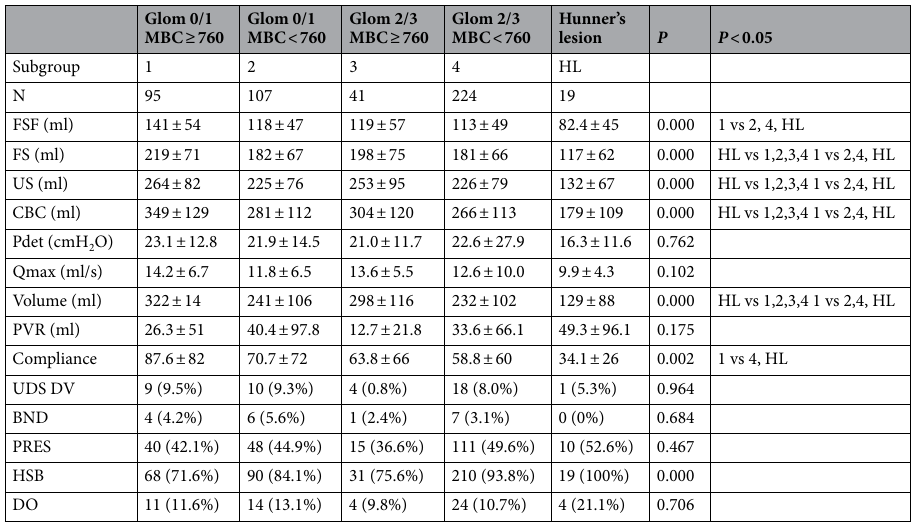
capacity (ml); FSF, first sensation of filling; FS, full sensation; US, urge sensation; CBC, cystometric bladder capacity; Pdet, voiding detrusor pressure; Qmax, maximum flow rate; PVR, post-void residual urine; UDS, urodynamic study; DV, dysfunctional voiding; BND, bladder neck dysfunction; PRES, poor relaxation of external sphincter; HSB, hypersensitive bladder; DO, detrusor